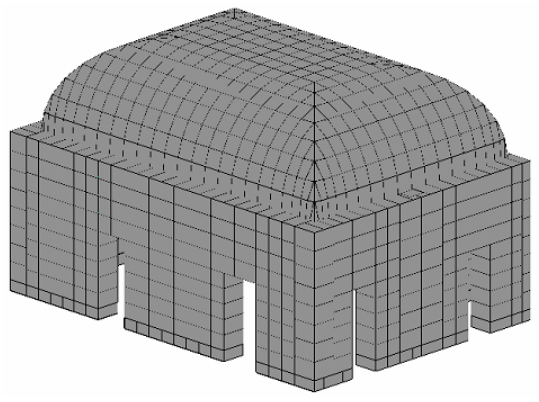
Figure 17. Axonometric view of the numerical model.